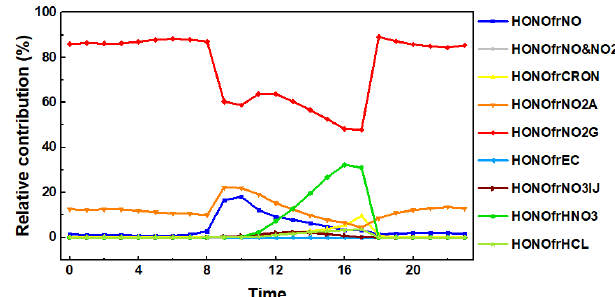
Figure 2. Relative contribution of different HONO reactions to near-ground-level HONO concentration in Beijing in December. The production from the NO + OH reaction is denoted as HON- OfrNO, the production from the NO + NO 2 + H 2 O reaction is de- noted as HONOfrNO&NO2, the production from nitro-cresol is de- noted as HONOfrCRON, the production from the heterogeneous reaction on ground surfaces is denoted as HONOfrNO2G, the pro- duction from the heterogeneous reaction on aerosol surfaces is de- noted as HONOfrNO2A, the production from the reaction of EC is denoted as HONOfrEC, the production from the photolysis of NO − is denoted as HONOfrNO3IJ, the production from the acid 3 displacement reaction of HNO 3 is denoted as HONOfrHNO3, and the production from acid displacement reaction of HCl is denoted as HONOfrHCL.